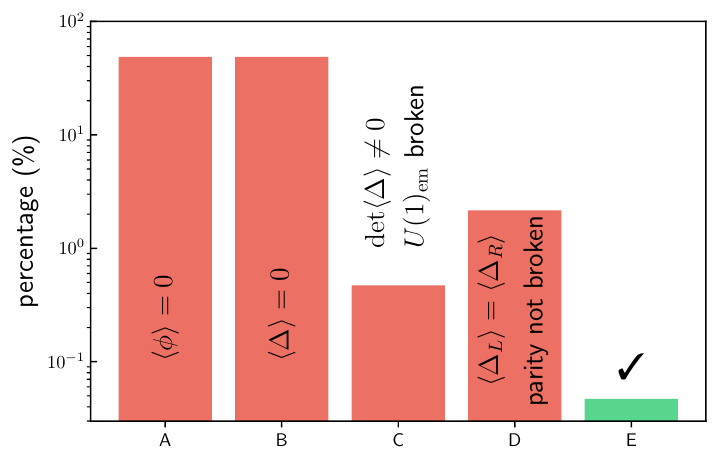
Figure 3 . Pecentages of the samples leading to the (cid:12)ve types of vacua (type A: 48.6%, type B: 48.7%, type C: 0.5%, type D: 2.2%, type E: 0.05%) classi(cid:12)ed by the conditions in eq. (3.18). Only type E corresponds to viable symmetry breaking of LRSM. More details of the (cid:12)ve types of